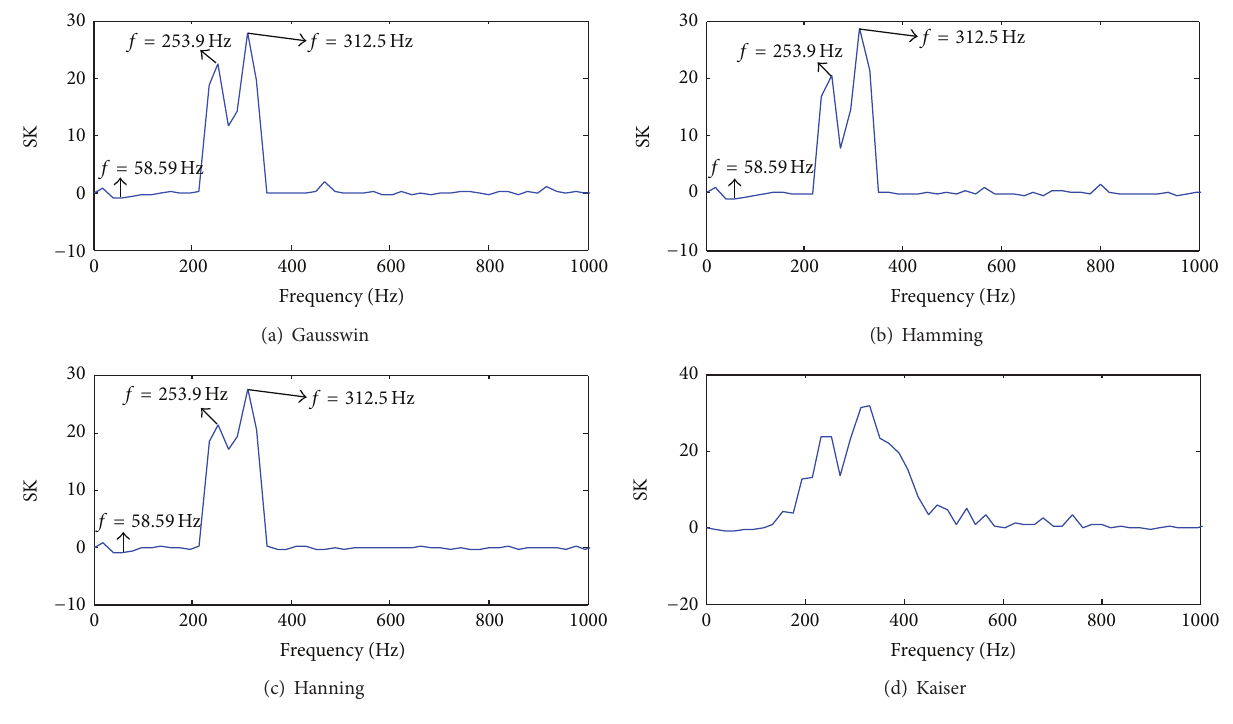
Figure 3: Types of window